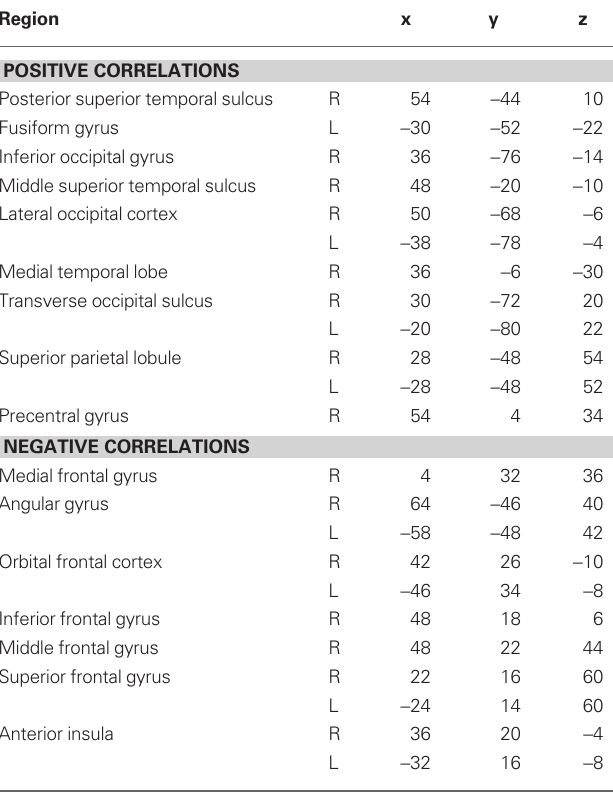
Table 2 | Resting partial Fg connectivity in experiment